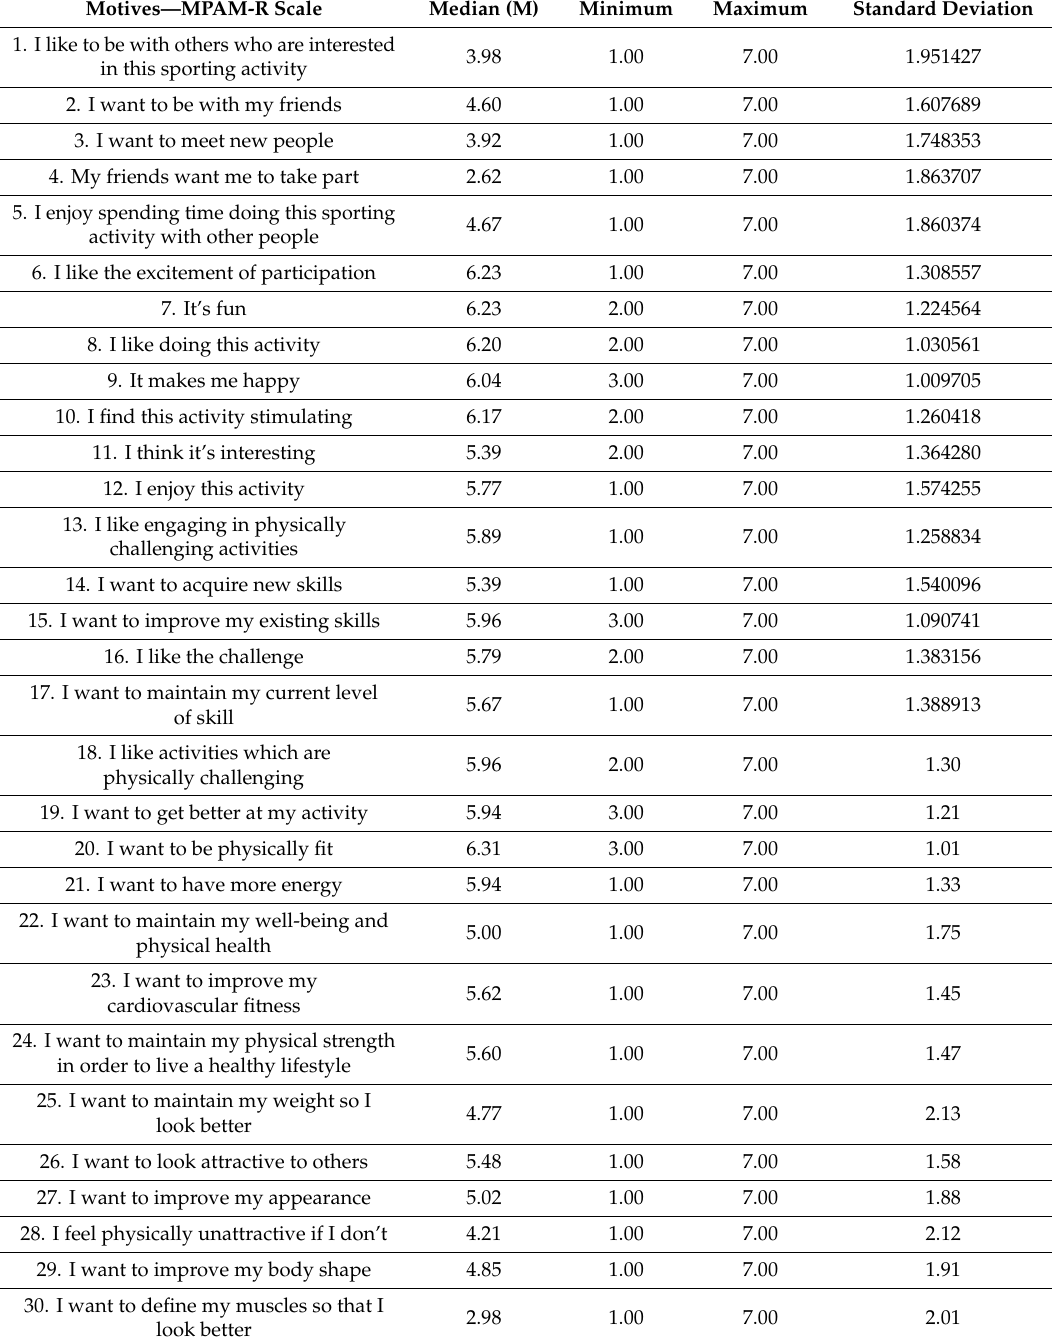
Table 2. Assessment of detailed MPAM-R